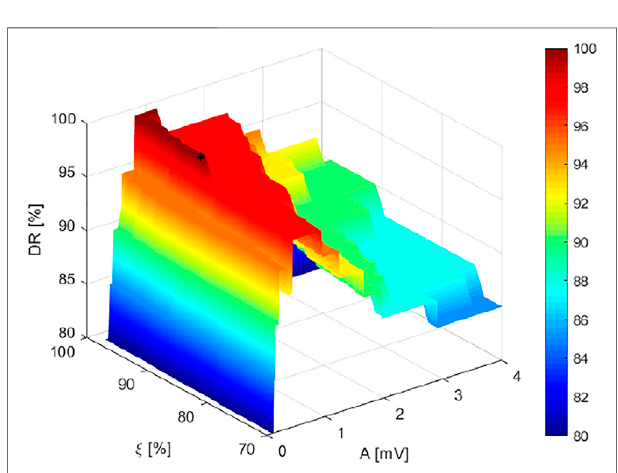
FIGURE 10 | Calibration step. DR versus ( A , ξ ) for HM. The optimal parameters ( A p , ξ p ) correspond to the asterisk.